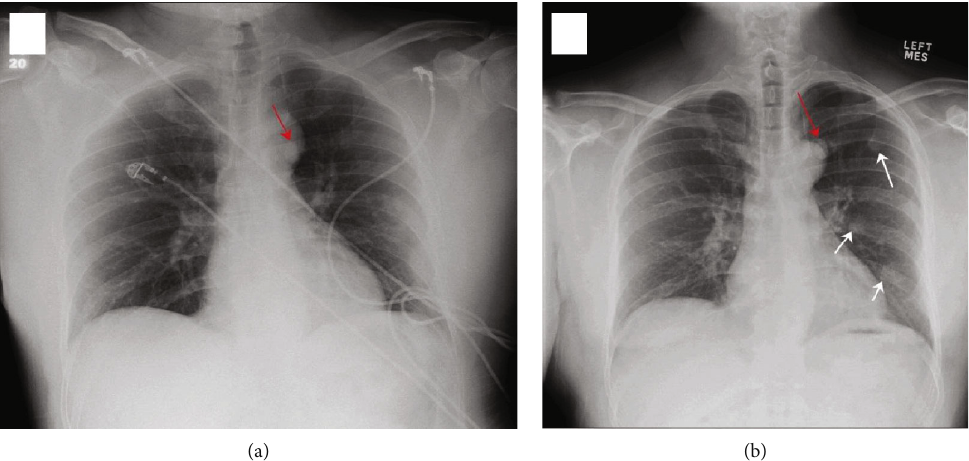
Figure 1: Chest X-ray. (a) Anteroposterior view showing a 1.7x1.4 cm nodular density at the level of aortic arch (red arrow). No other de fi nitive nodules were seen. (b) Posteroanterior radiograph six months later, revealing the previously noted nodular density (red arrow) that remains unchanged and several new nodular opacities (white arrows) in the left upper and left lower lung fi